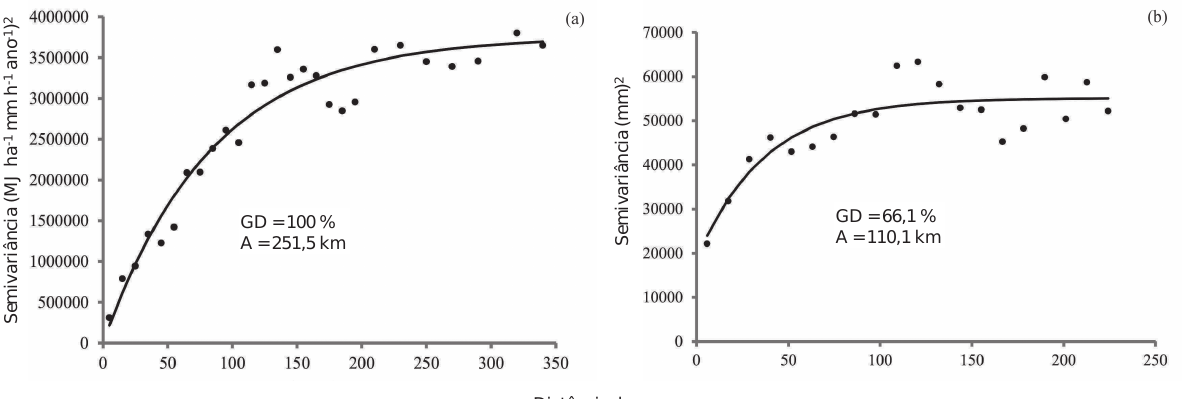
Distância, Figura 3. Semivariogramas ajustados para a erosividade anual (a) e precipitação anual (b) para o Estado do Espírito Santo (GD: grau de dependência espacial).